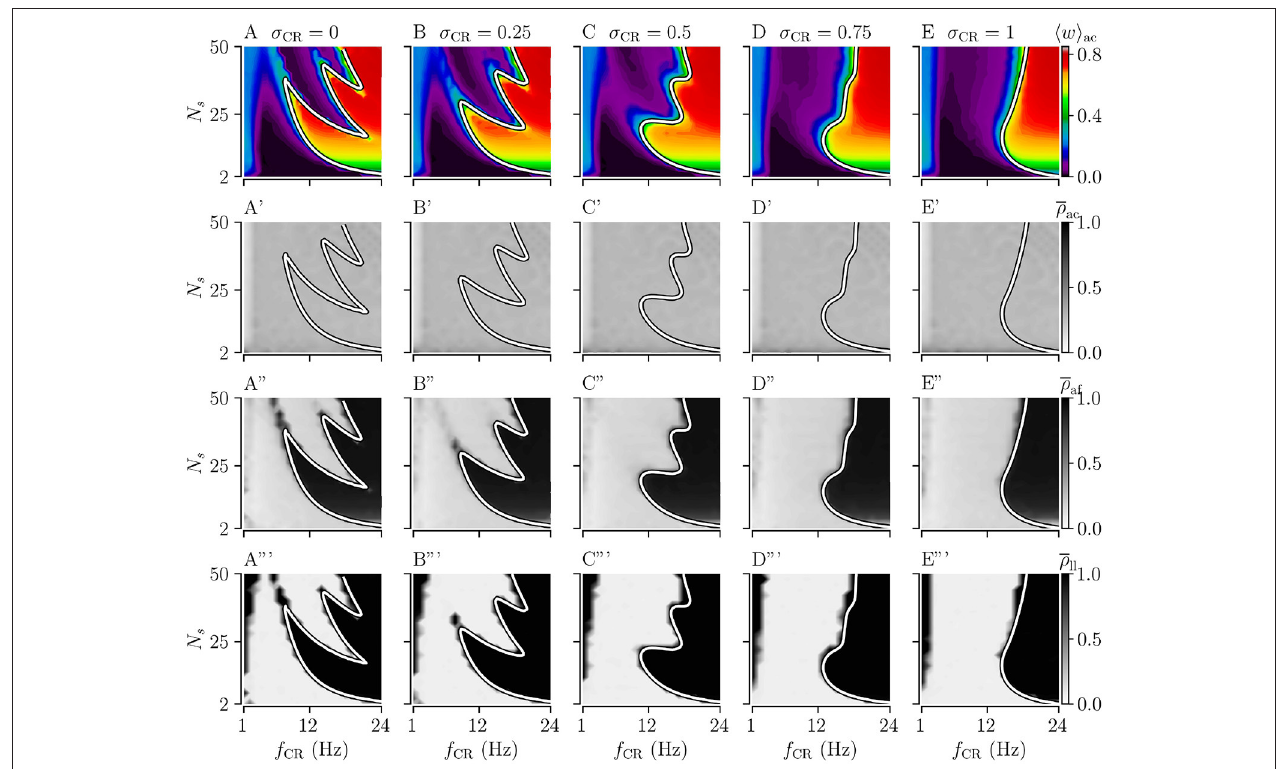
FIGURE 3 | Acute, acute after-, and long-lasting effects of Noisy CR (NCR) with different values of the stimulus jitter, σ CR , as a function of the stimulation frequency and the number of stimulation sites for strong stimulation. (A–E) Simulation results for the acute mean synaptic weights, h w i ac , at the end of the 1,000 s stimulation duration; (A’–E’) The acute Kuramoto order parameter, ρ ac , time-averaged over the last 10 s of the stimulation duration; (A”–E”) The acute after-effect on synchronization as quantified by the Kuramoto order parameter, ρ af , time-averaged over a 10s interval after cessation of the stimulation; (A”’–E”’) Long-lasting desynchronization effects for respective stimulus jitters, as quantified by the Kuramoto order parameter, Equation (2), averaged over a 10s interval 1,000 s after cessation of stimulation, ρ ll . (A,A’,A”,A”’) show results for σ CR = 0 which are similar to Kromer et al. (2020) but for longer stimulation durations. The white curves show theoretical estimates of the boundary between weakening and strengthening of interpopulation synapses, see Figure 2 . Parameters: The stimulation duration was set to T stim = 1,000 s and A stim =